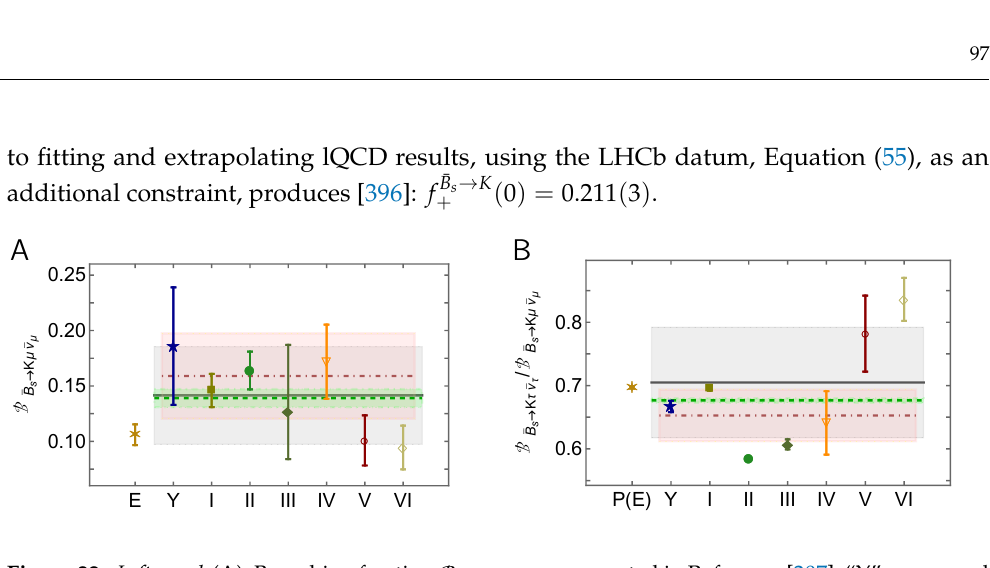
Figure 22. Left panel ( A ): Branching fraction B ¯ B 0 s → K + µ − ¯ ν µ computed in Reference[207], “Y”, compared with the value in Equation (55), “E”, viz. a measurement of B B 0 − µ + ν µ [391], and some results s → K obtained using other approaches: continuum I–III [393–395]; lattice IV–VI [389,390,392]. Right B ¯ panel ( B ): Branching fraction ratio B ¯ B 0 s → K + τ − ¯ ν τ / B 0 s → K + µ − ¯ ν µ computed in Reference[207] compared with some results obtained using other approaches. The legend matches Panel A , except “P(E)” is the result from [396], i.e., an estimate constrained by the datum in Reference[391]. Both panels: Grey line: unweighted mean of theory results. Pink dotted-dashed line: unweighted mean of theory results, omitting V–VI . Green dashed line: uncertainty-weighted average of theory results. Like-coloured bands mark associated uncertainties in each